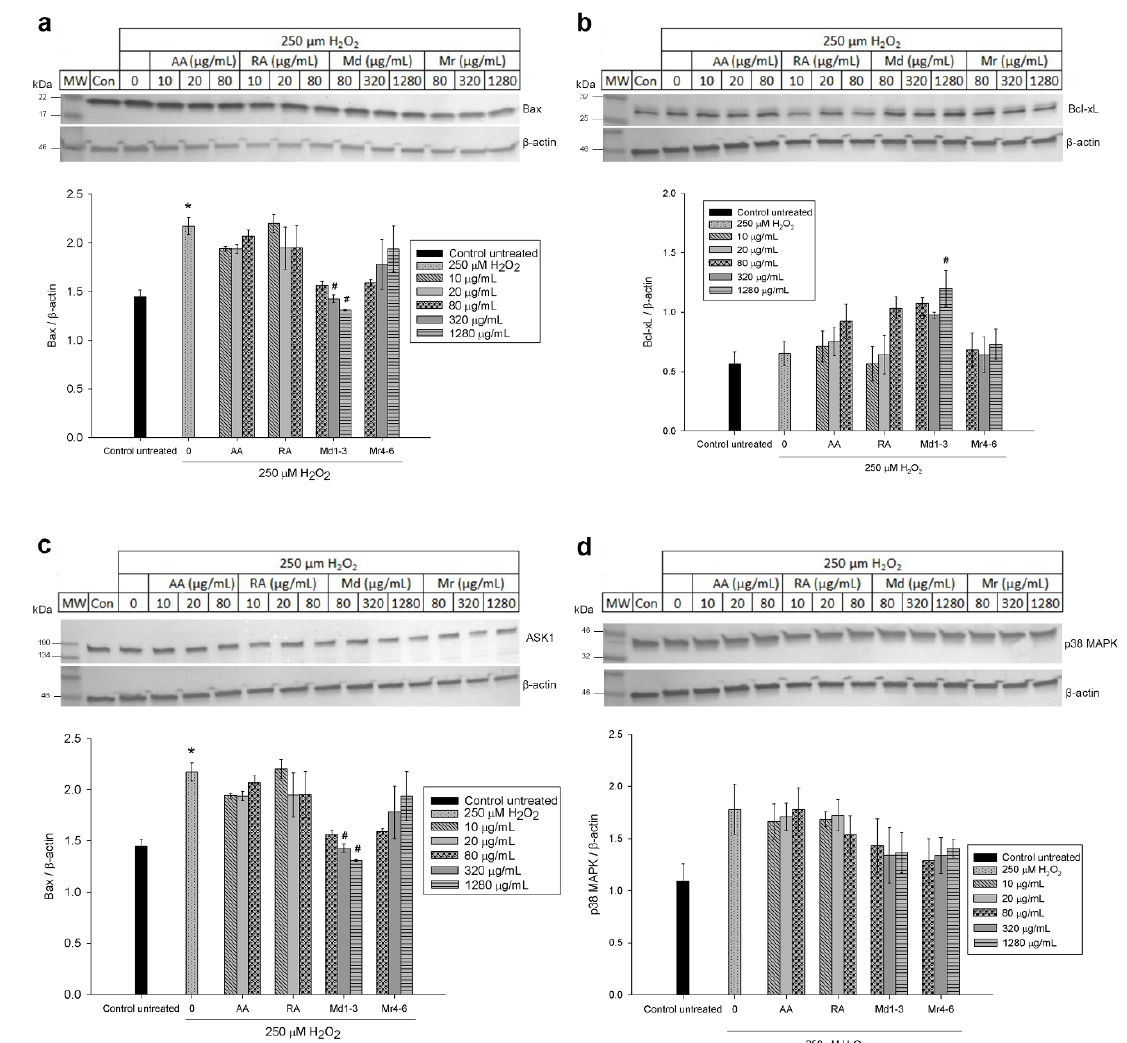
Figure 5. Western blot analysis of different concentrations of ascorbic acid, rosmarinic acid and mint extracts on the expression of ( a ) Bax; ( b ) Bcl-xL; ( c ) ASK1 and ( d ) p38 MAPK in H 2 O 2 -induced damage in SH-SY5Y cells. Results are presented as mean ± standard error (SE) ( n = 3). * indicates that treatment with H 2 O 2 is significantly different ( p < 0.05) from control untreated cells, # indicates that pretreatment